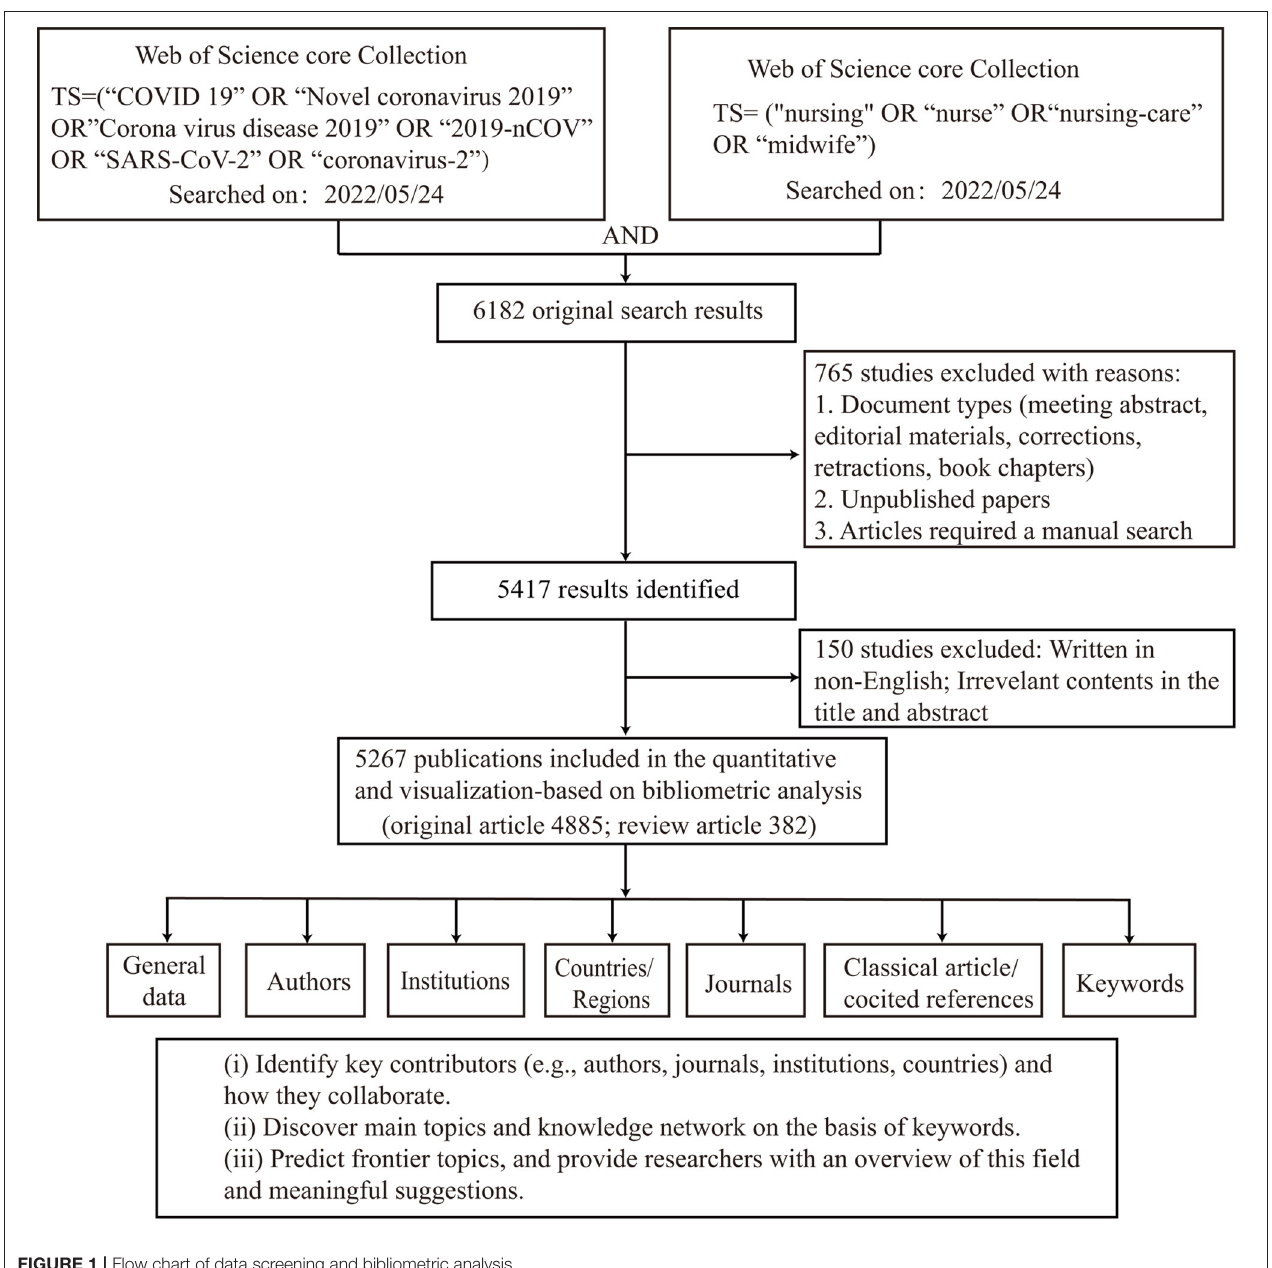
FIGURE 1 | Flow chart of data screening and bibliometric